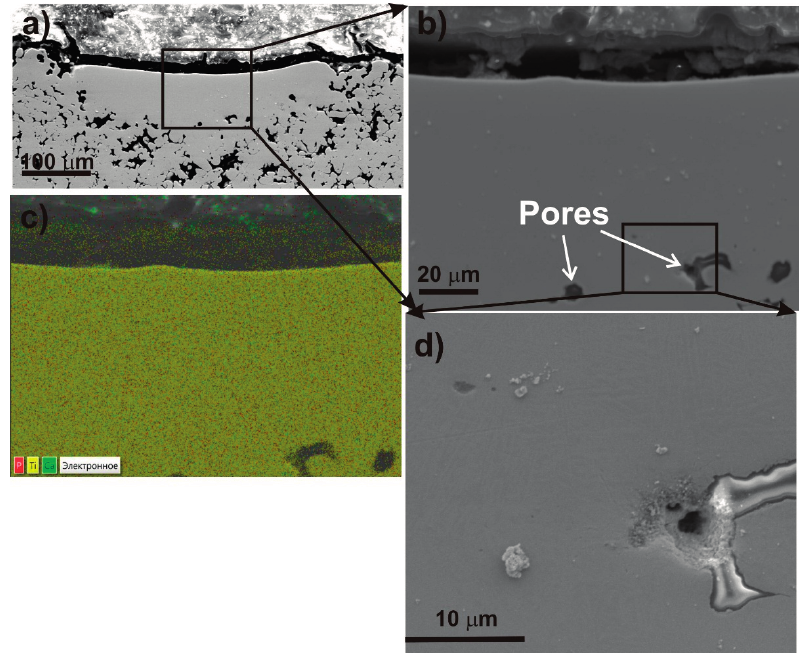
Figure 6. SEM of the CS coating after laser treatment: ( a ) regime of LI is presented in Figure 4b; ( b , d ) microstructure peculiarities under high magnification; and ( c ) the EDS microanalysis for whole area of Figure